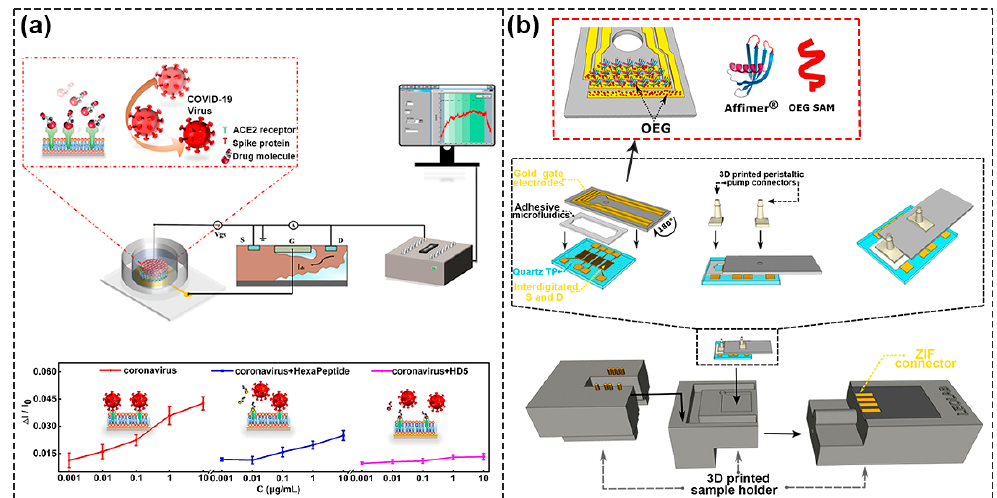
Figure 11. Schematic of integrated FET biosensors with microfluidic for lab − on − chip. ( a ) Schematic of biosensor chip modified by SLB ( top ) and the inhibitory response of two different drugs to the interaction between coronavirus and ACE2 receptor ( bottom ). Reproduced with permission from [89]. Copyright 2022, American Chemical Society. ( b ) Schematic of a lab − on − chip multi − gates or- ganic transistor based on 3Dprinting and modified multi − gates in the red dotted box. Reproduced with permission from [91]. Copyright 2020, American Chemical Society.